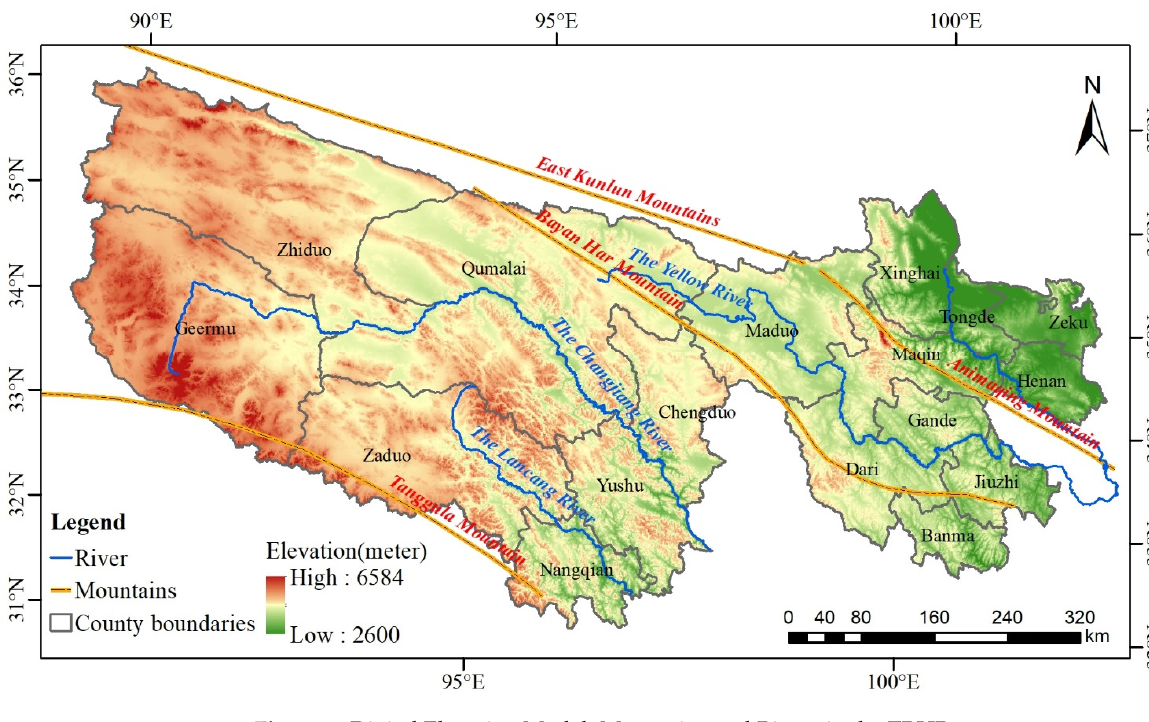
Figure 1. Digital Elevation Model: Mountains and Rivers in the TRHR.